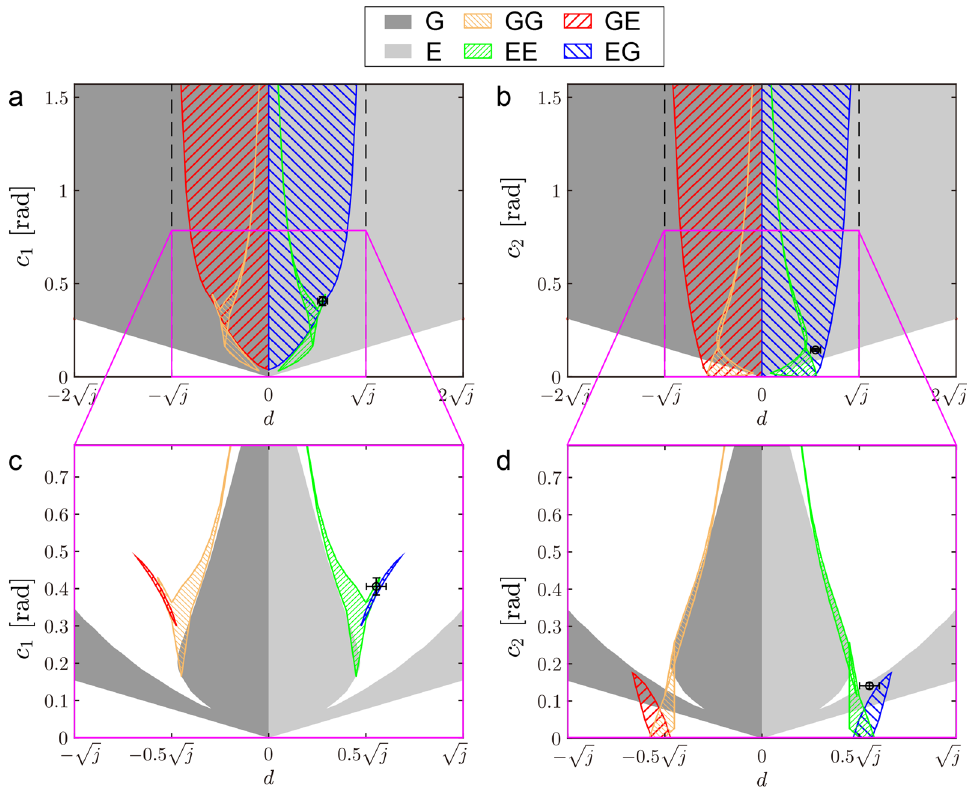
Figure 6. Solution type for d and c 1 ( a ), and d and c 2 ( b ). Stable solutions among solutions in a focused range of d and c 1 ( c ), and d and c 2 ( d ). Black circles and error bars show average values and standard errors of measured animal data,